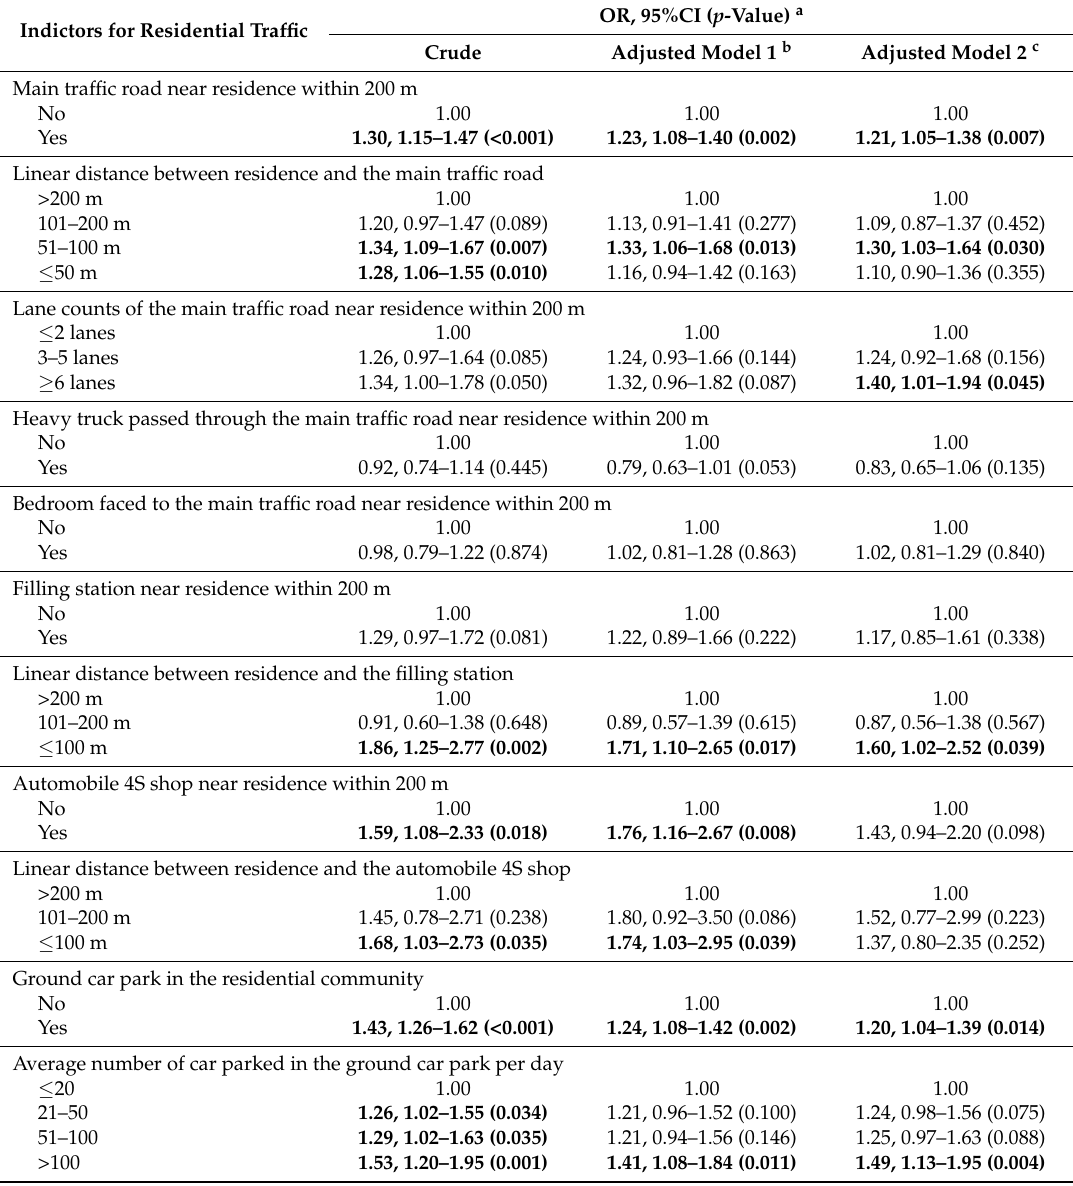
Table 3. Associations of childhood pneumonia with residential traffic in the logistic regression